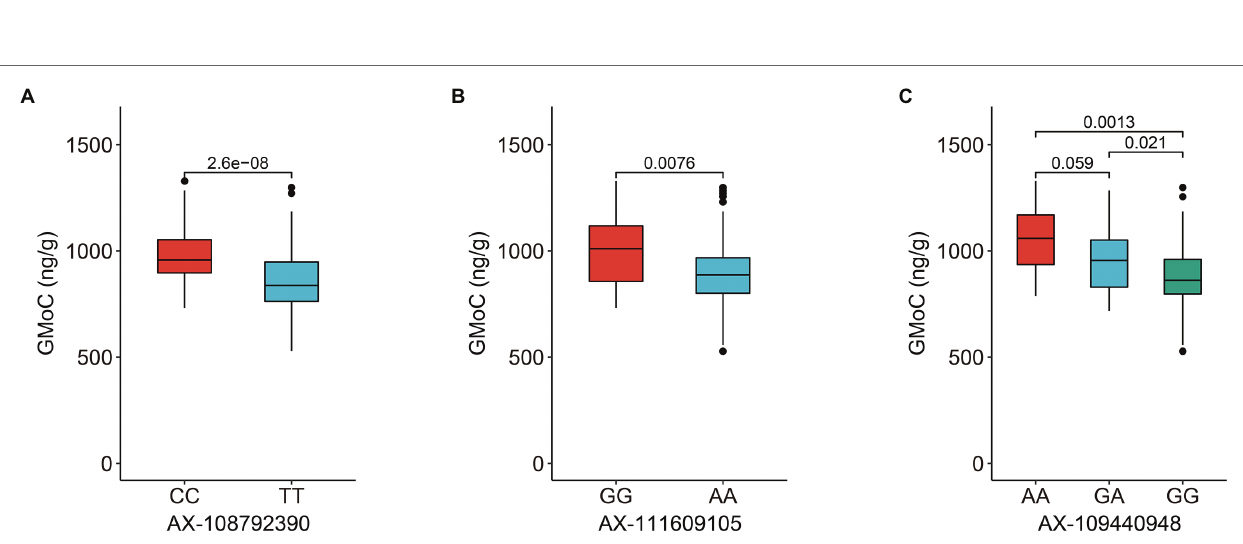
FIGURE 3 | Phenotypic differences in grain Mo concentration of wheat accessions carrying different genotypes of three most significant SNPs on chromosome 2A, 7B, and 7D, respectively. (A) AX-108792390 at the position of Chr2A: 727,180,360 bp. (B) AX-111609105 at the position of Chr 7B: 611,944,380 bp. (C) AX- 109440948 at the position of Chr 7D: 611,243,842